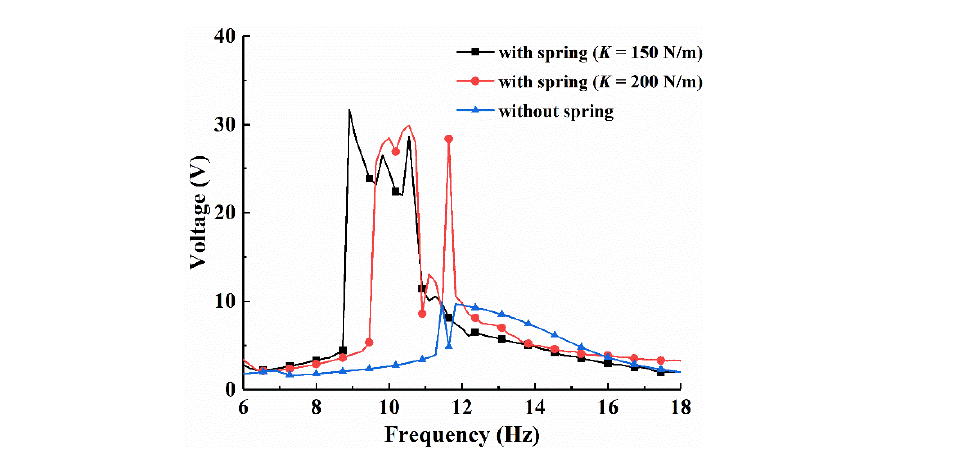
Figure 12. Frequency-swept voltage response of the system with different spring stiffness under excitation amplitude A = 5 m/s 2 .